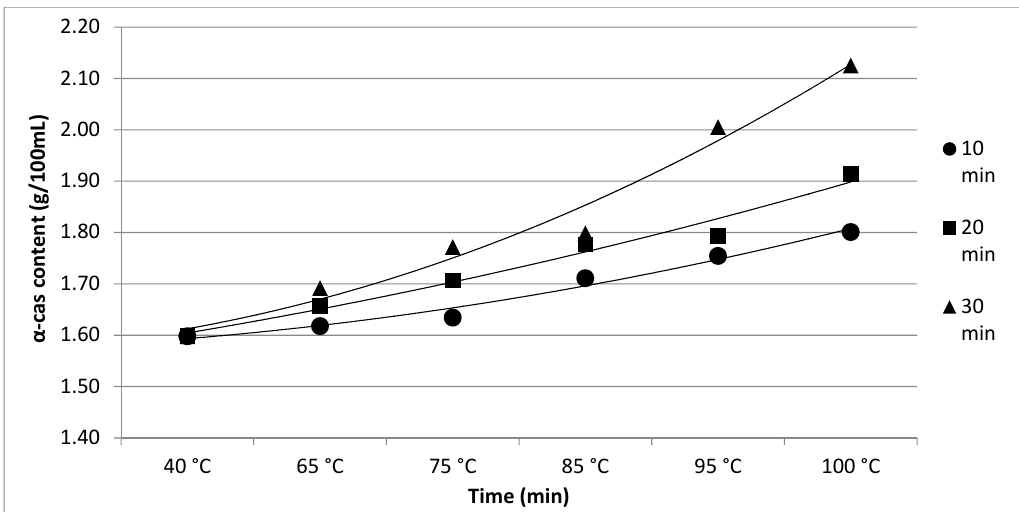
Figure 1. Effect of heating time and temperature on α -cas content. Equations: 10 min (y = 0.0043x 2 + 0.0127x + 1.5763; R 2 = 0.9794), 20 min (y = 0.0031x 2 + 0.0373x + 1.5641; R 2 = 0.9733), 30 min (y = 0.0114x 2 + 0.0235x + 1.5778; R 2 =